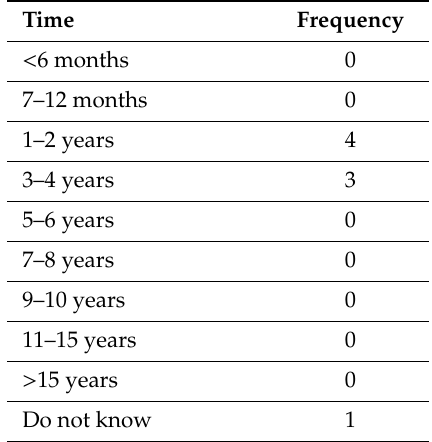
Table 14. Expectation of time to satisfaction (N = 8).